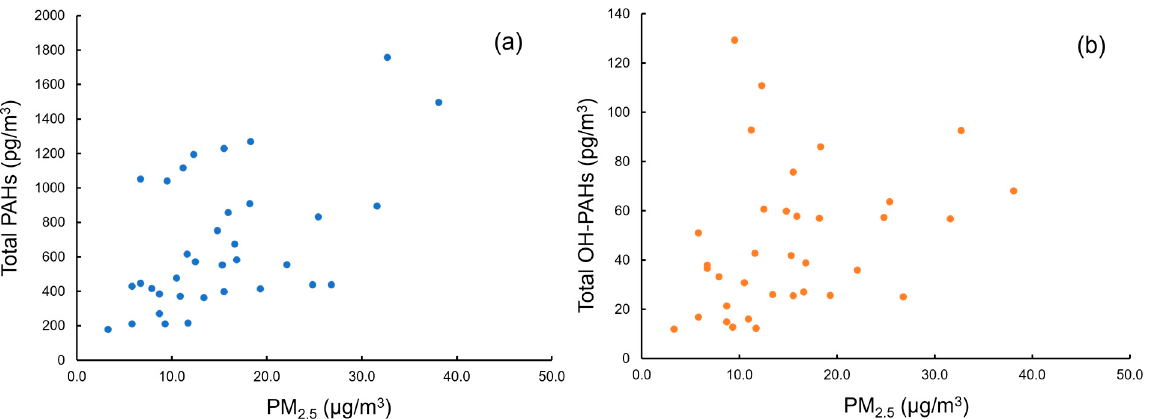
Figure 4. Correlation between the atmospheric concentrations of the target compounds and PM 2.5 : ( a ) total PAHs versus PM 2.5 , and ( b ) total OH-PAHs versus PM 2.5 .